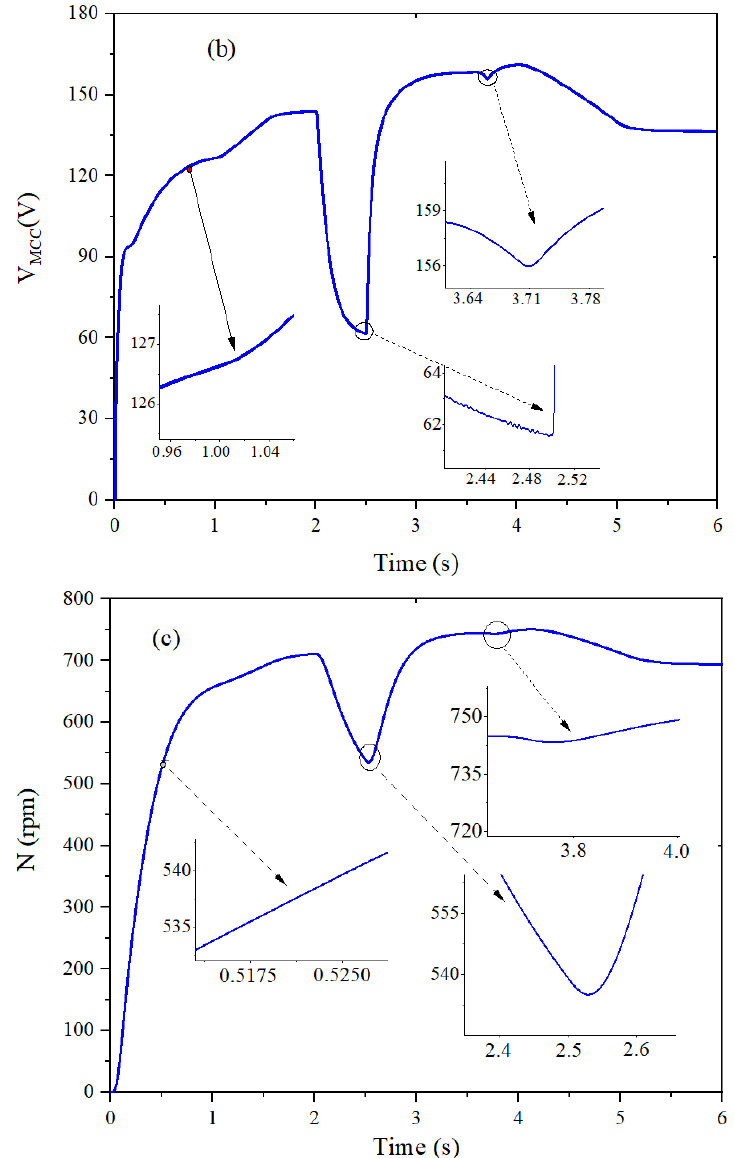
Figure 15. Simulation results associated with the FL-INC technique. ( a ) Instantaneous power extracted from the GPV, ( b ) terminal voltage at the pump motor, ( c ) rotation speed of the pump motor.